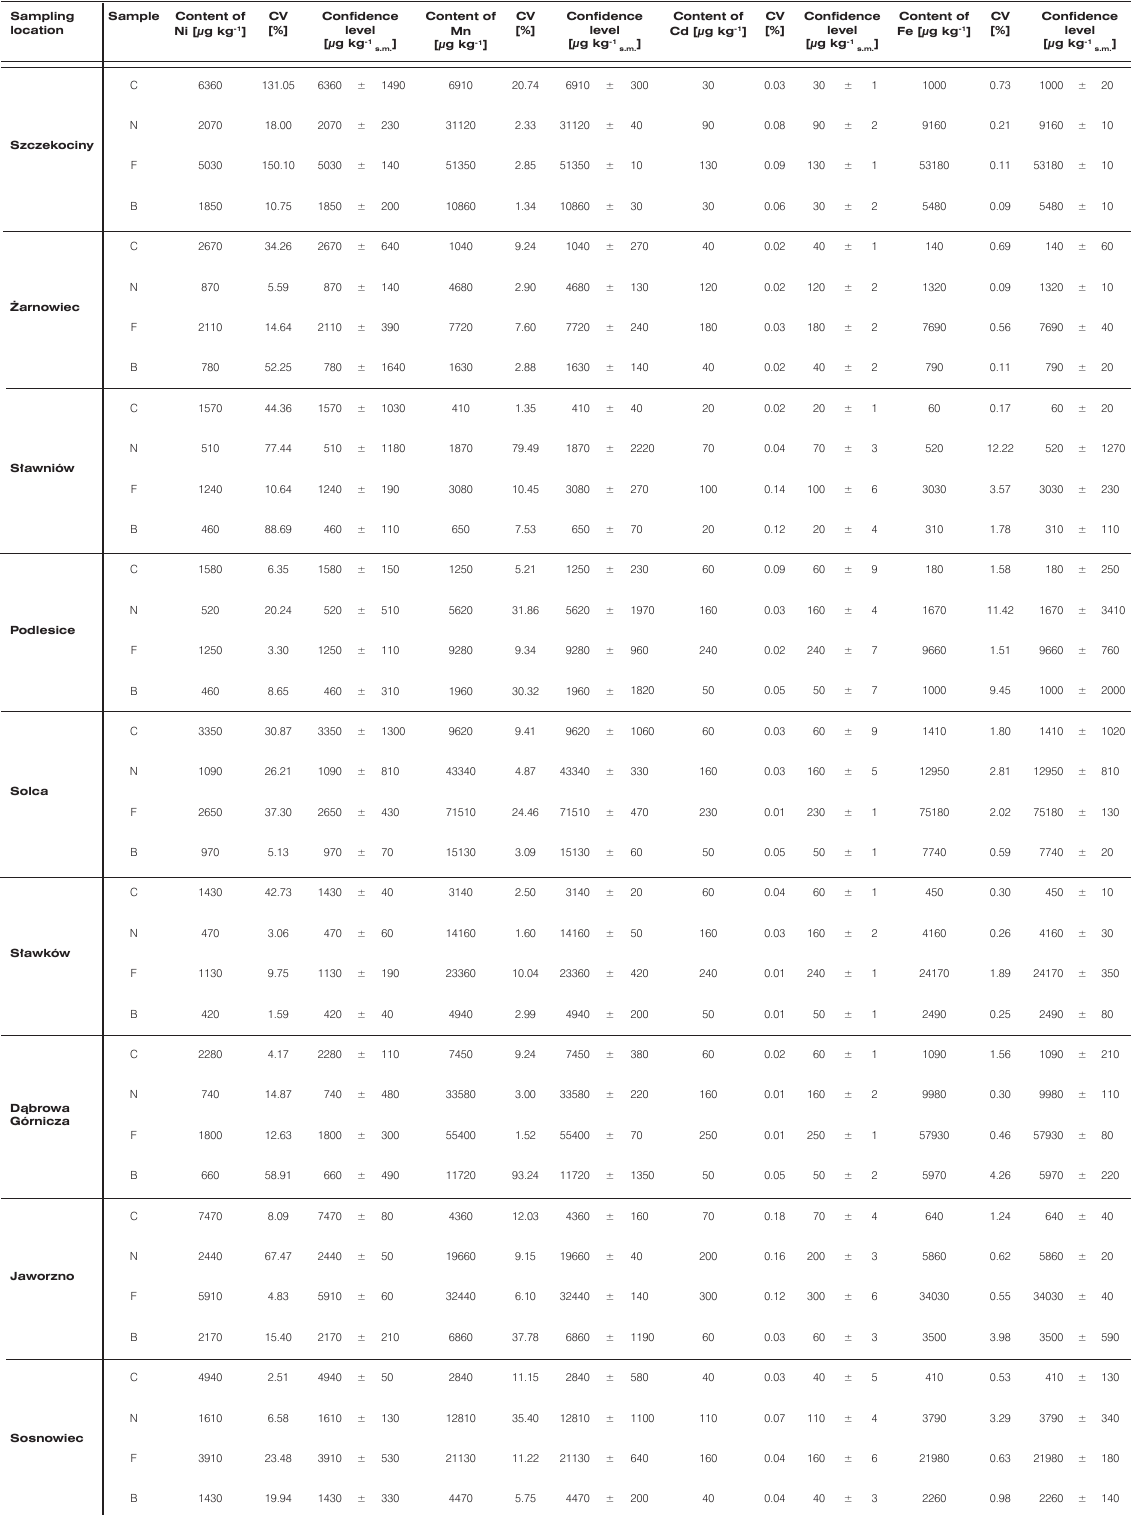
Table 3. Average content of indicated metals in respective sampling locations, cont. Sampling